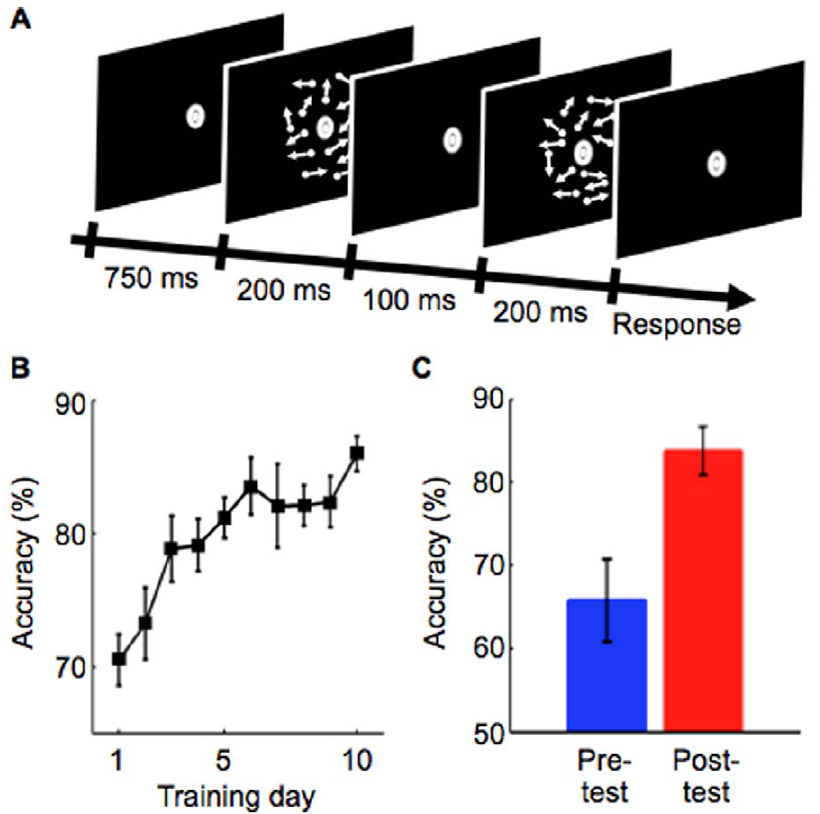
Figure 1. Task procedure and results of the behavioral session. (A) The 2IFC global motion detection task in the behavioral session. One stimulus interval contains 15% coherent motion while the other interval contains random motion (0% coherence). After two motion presentations, the subjects were asked to report the interval (first or second) which contained 15% coherent motion. (B) Mean performance across the subjects during the training stage. A motion direction used in this stage was defined as a trained direction for each subject. After 10-day training, a significant training effect was obtained (day 1 vs day 10, paired t-test, P , 10 2 4 ). Error bars represent SEM. (C) Mean behavioral performance across the subjects for the trained direction in the pre-test (blue) and post-test (red) stages. Significant performance improvement was found after the training stage (paired t-test, P= 0.01). Error bars represent SEM.